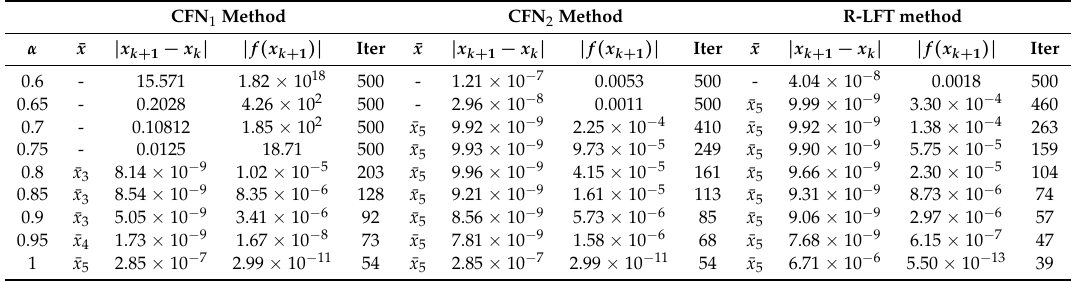
Table 3. Fractional Newton and Traub-type results for f 1 ( x ) with Caputo derivative and initial estimation x 0 = 10 4 i .